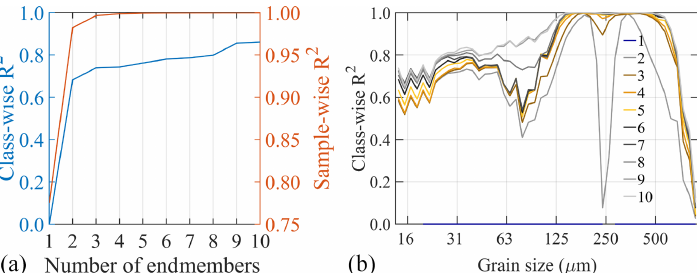
Figure A12. Median class-wise and sample-wise R 2 for D2d endmember modelling results of the dune dataset (a) and size-resolved class- wise R 2 (b) .